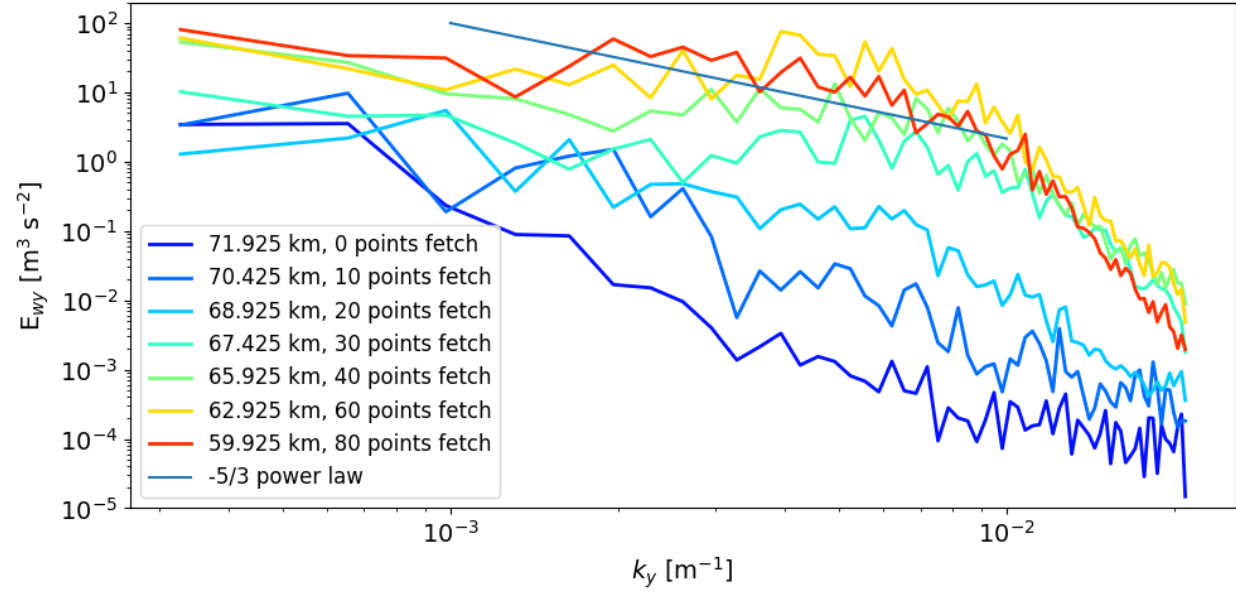
Figure 11. Spectral density of vertical velocity from 128 point y-transects at different x locations and points of fetch from the eastern inflow boundary of d03_30s_ref. Model data are from the seventh vertical level, and averaged over 13 times from model output at 2.5 min intervals over the 30 min centered about 1715 UTC, roughly concurrent with the 1716 radiosonde release on 20 May